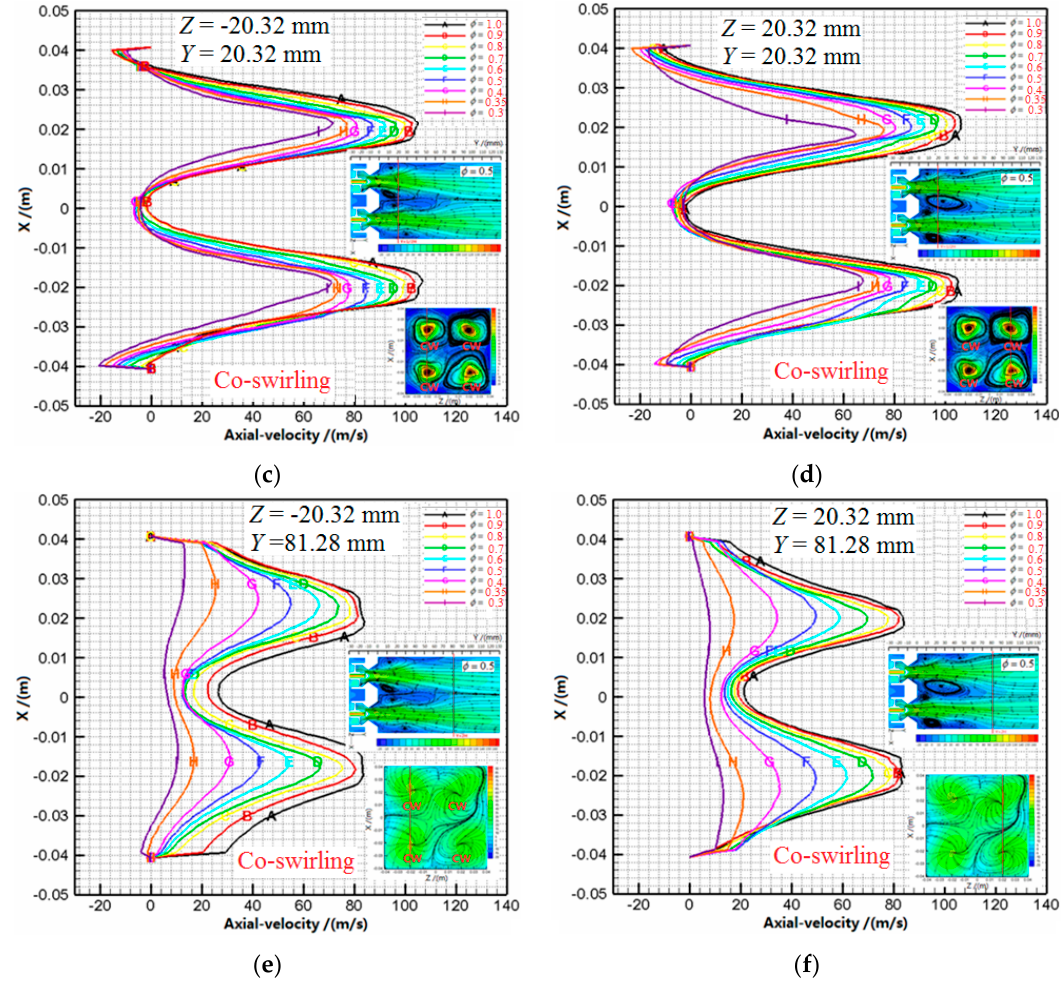
Figure 4. Axial velocity profiles and contours compared for co-swirling four-point LDI combustors with different equivalence ratios.